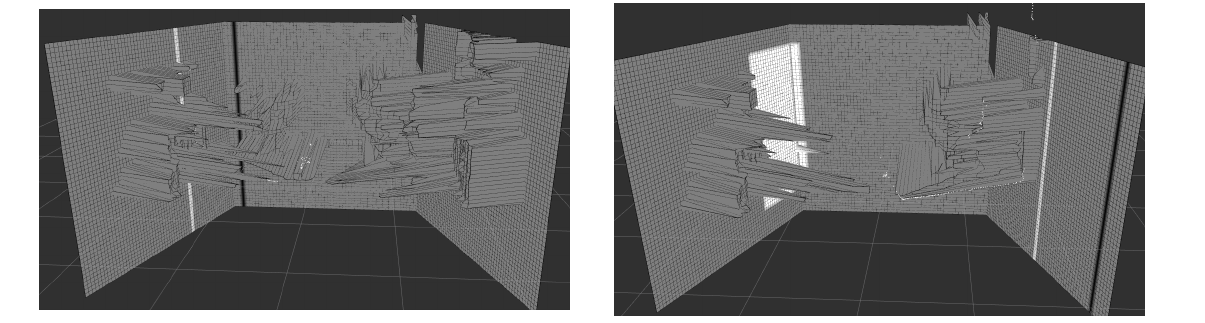
Figure 16. Results of the human detection experiment showing environment before and after a human is identified. The surface generated from its scanning is removed from the local